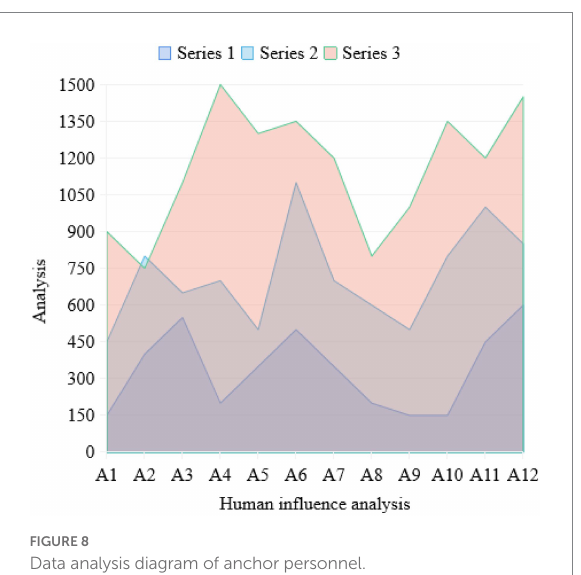
FIGURE 8 Data analysis diagram of anchor